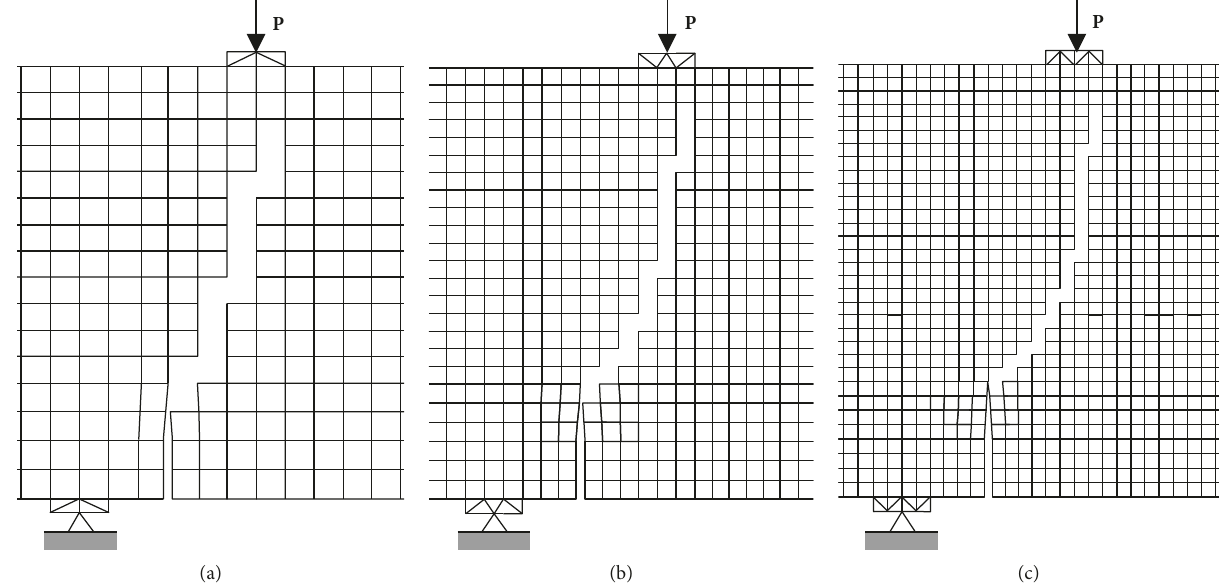
Figure 18: Computed final crack patterns in the central part of the SEN concrete beam: (a) coarse mesh; (b) medium mesh; (c) fine